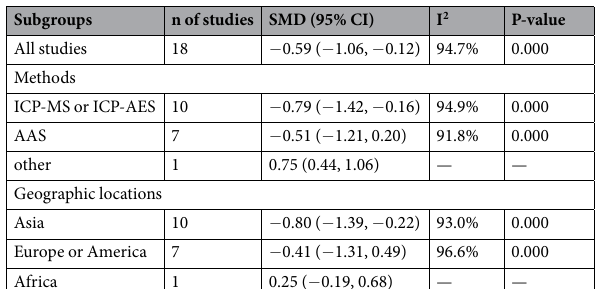
— — Table 2. Meta-analysis of studies on serum. SMD with the corresponding 95% CI and p value, the I 2 statistic for overall and subgroup analyses. SMD, Standardized mean difference; CI, confidence